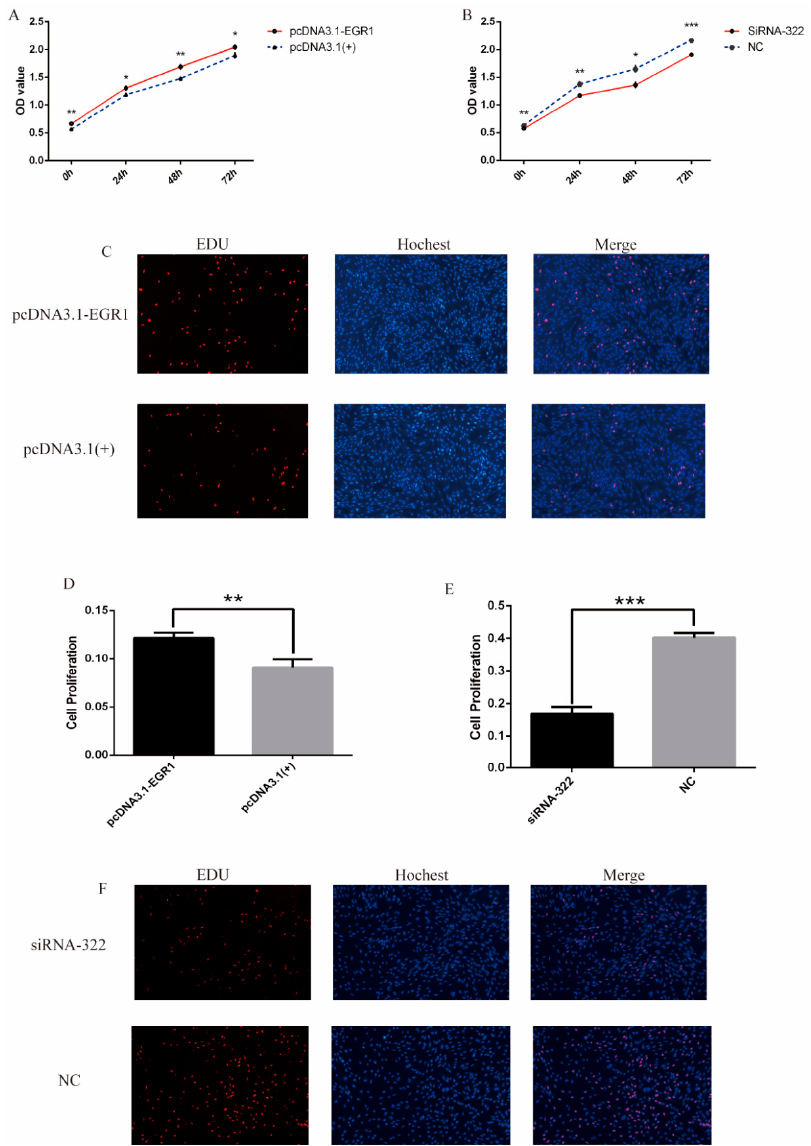
Figure 5. Effect of EGR1 on the proliferation of DPCs. ( A ) The dermal papilla cell activity after overexpression of EGR1 by CCK-8. ( B ) The dermal papilla cell activity after EGR1 down-regulation by CCK-8. ( C , D ) The proliferation rate of DPCs after overexpression of EGR1 by EDU immunofluores- cence (100 × ). ( E , F ) The rate of proliferating cells after EGR1 down-regulation (100 × ). “*” represents a significant difference ( p < 0.05), “**” represents a highly significant difference ( p < 0.01), “***” repre- sents an extremely significant difference ( p <